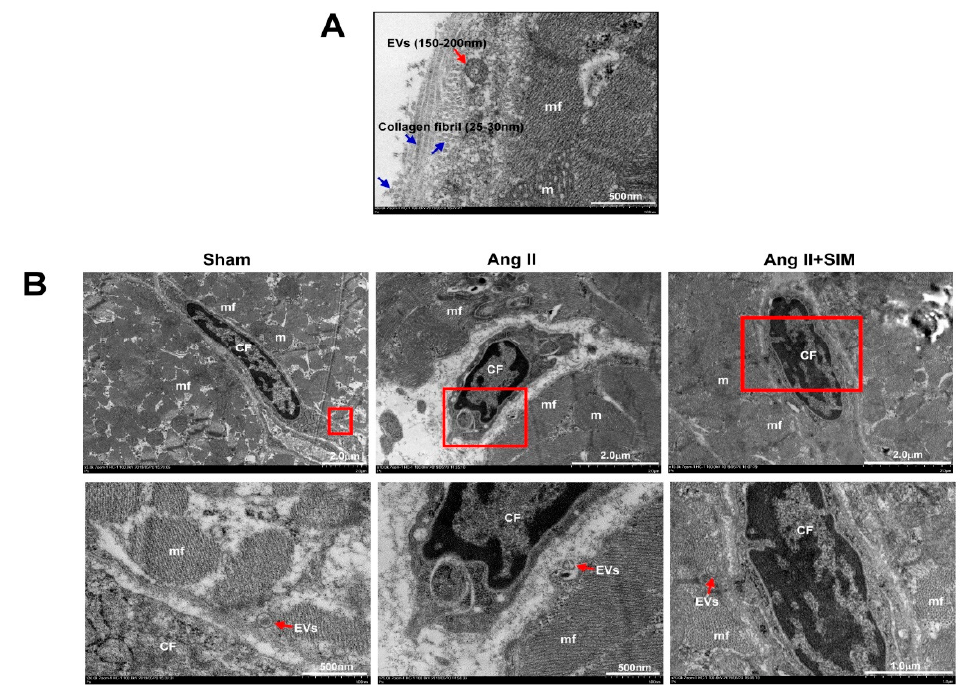
Figure 2. Ultrastructure between CM and CF of the heart in vivo. The SD rats were divided into sham group, Ang II group and Ang II + SIM group (each group n = 6). TEM images of rat left ventricles demonstrated the morphology, size of longitudinal and cross-sectional collagen fibers, and extracellular vesicles (EVs) ( A ). The distribution of EVs between CM and CF was explored by TEM analysis ( B ) (mf, myofibril; m, mitochondrial; CF, cardiac fibroblast).